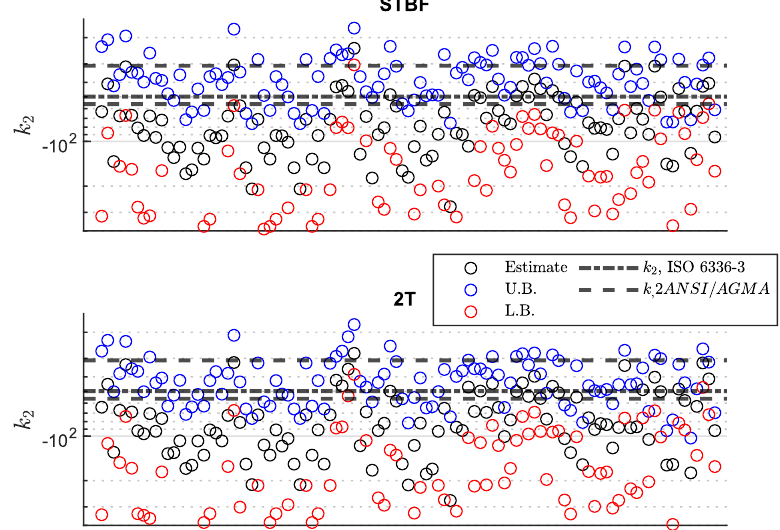
(and its confidence interval) with its standard 𝑘𝑘 2